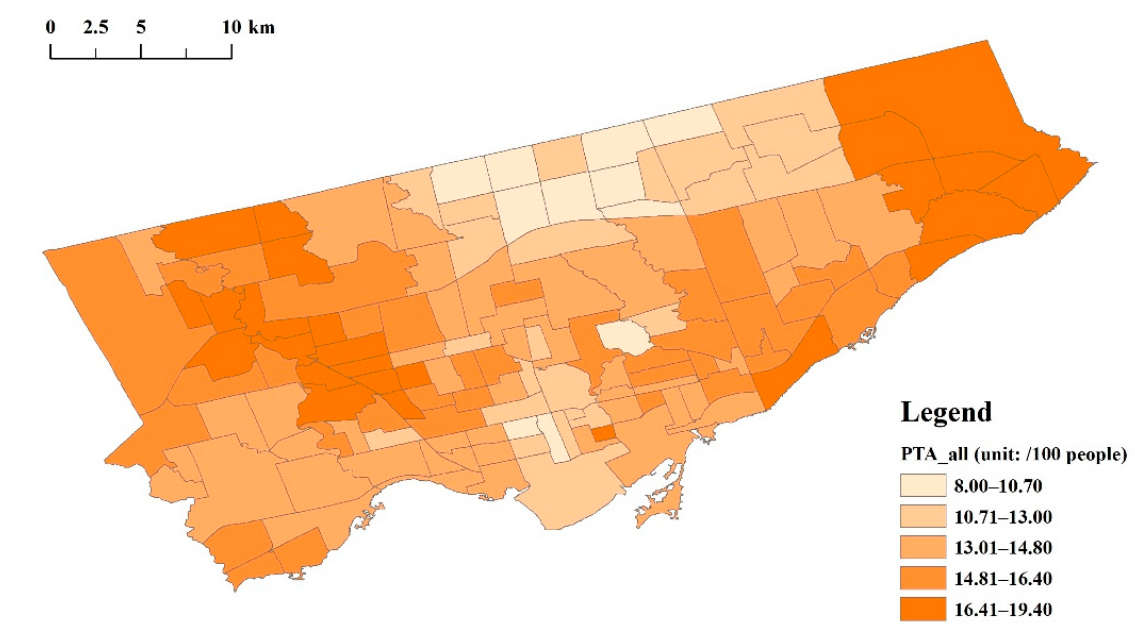
Figure A3. Distribution of the prevalence of total asthmatics at all ages (PTA_all).